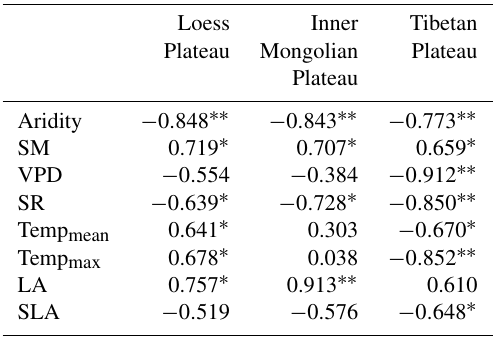
Table 1. The Pearson correlation coefficients for correlations of community 1 /(cid:49) 18 O with environmental factors and with plant properties. Loess Inner